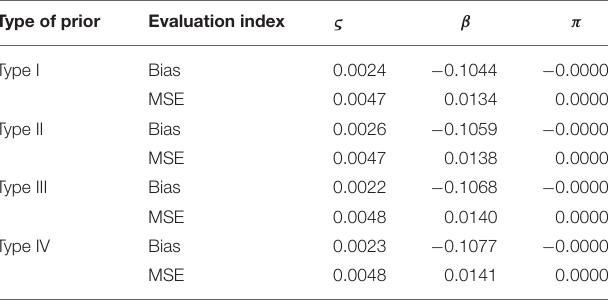
TABLE 4 | Evaluating the accuracy of parameters based on different prior distributions in the simulation study 3. Type of prior